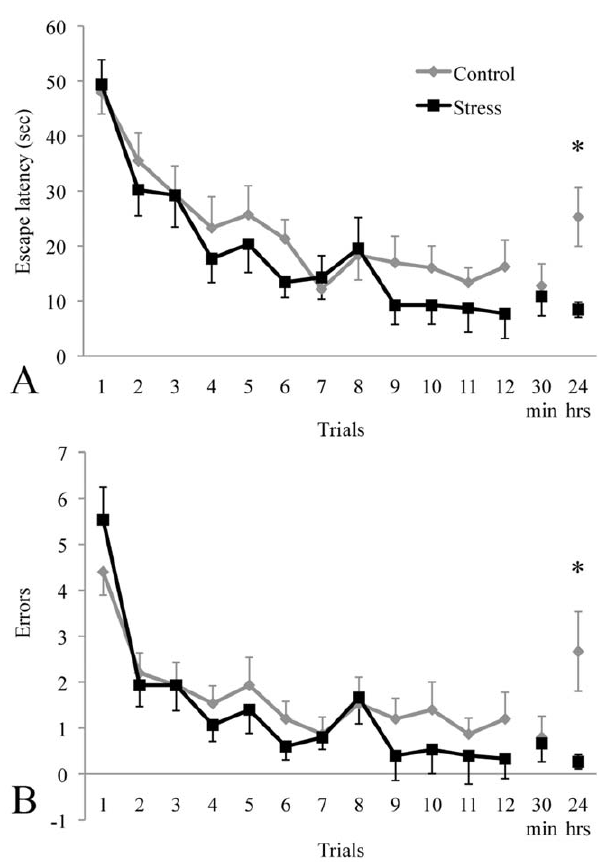
Figure 2. CUS facilitated long-term spatial memory in the RAWM. Escape latencies did not differ between control and stressed animals during the acquisition trials (1–12), or on the short-term memory trial (30 min) (A). However, stressed animals took significantly less time to locate the hidden platform on the long-term memory trial (24 hrs). A similar pattern was seen for errors made during search (B). * significantly different from control.